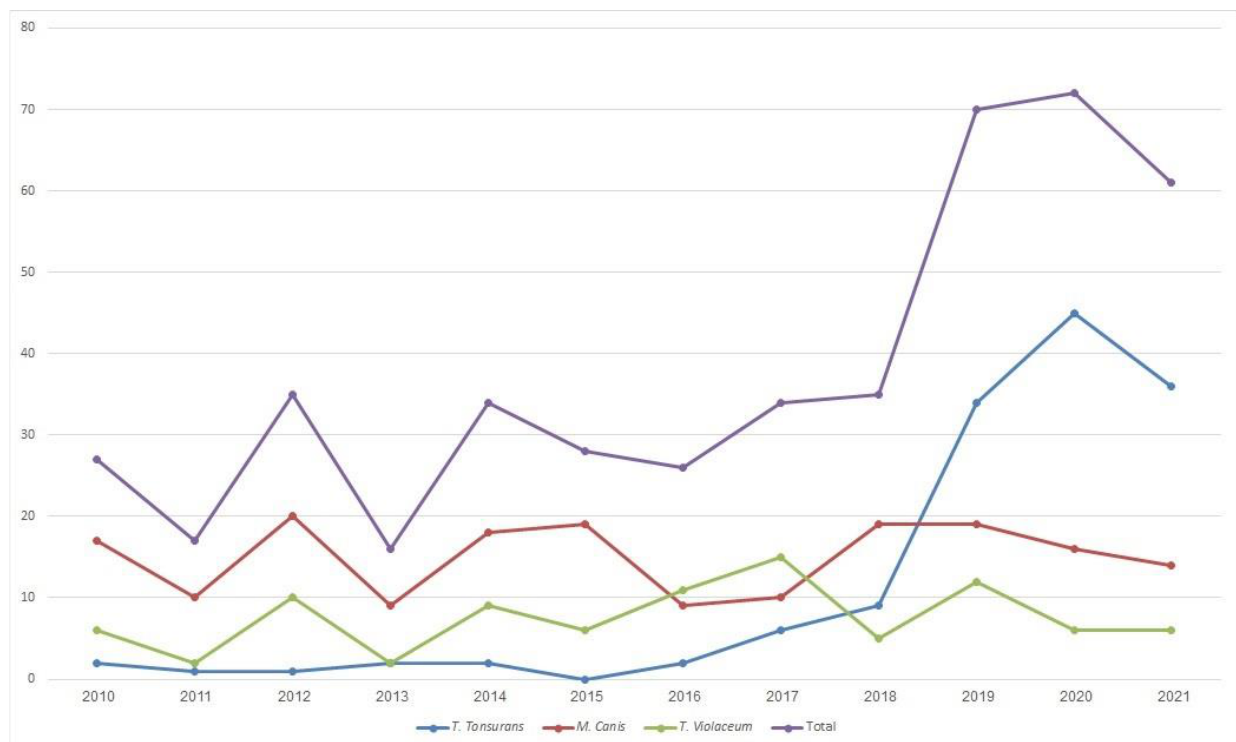
Figure 1. Annual incidence of tinea capitis per species.